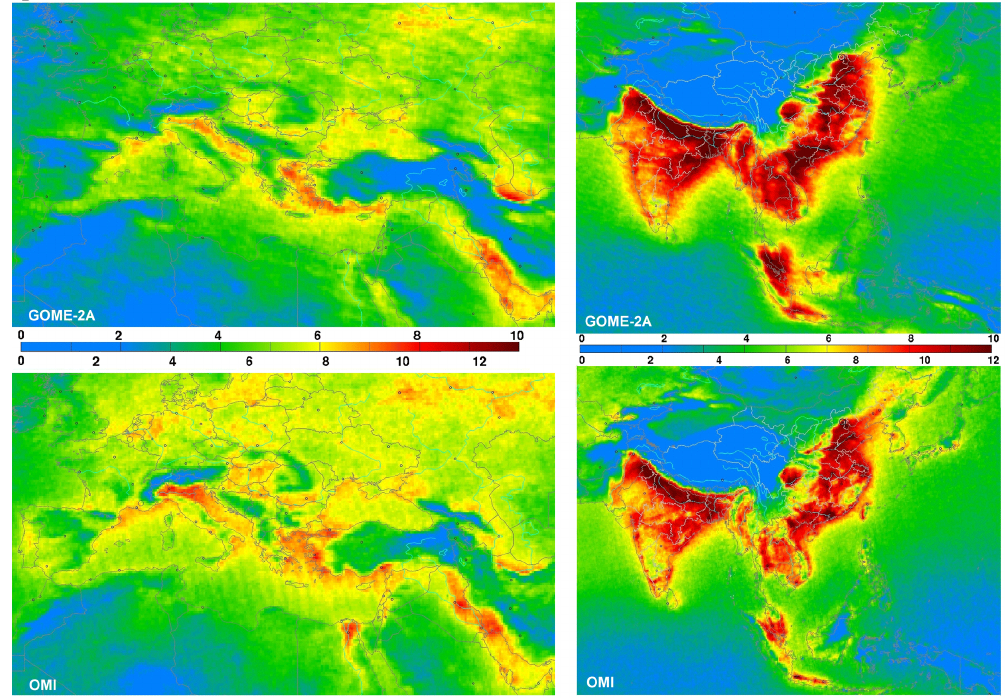
Figure 9. H 2 CO vertical columns retrieved from GOME-2/MetOp-A (first row) and OMI/Aura (second row) over Europe (from April to September) and Asia (from February to November), between 2007 and 2013. Note that different colour scales have been used for GOME-2 and